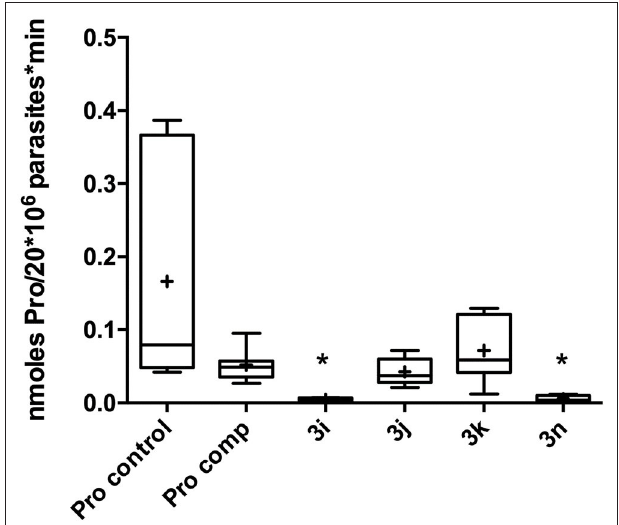
FIGURE 4 | Proline uptake assay. Pro control = Proline control, Pro comp = L-Proline as competitor. 3i-k and 3n = proline level incubated (* p < 0.05) with selected analogs. Pro control (0.31mM L-proline, [ 3 H] proline, PBS). Pro Comp (3.1mM L-proline, [ 3 H] proline, PBS). Compounds 3i-k and 3n